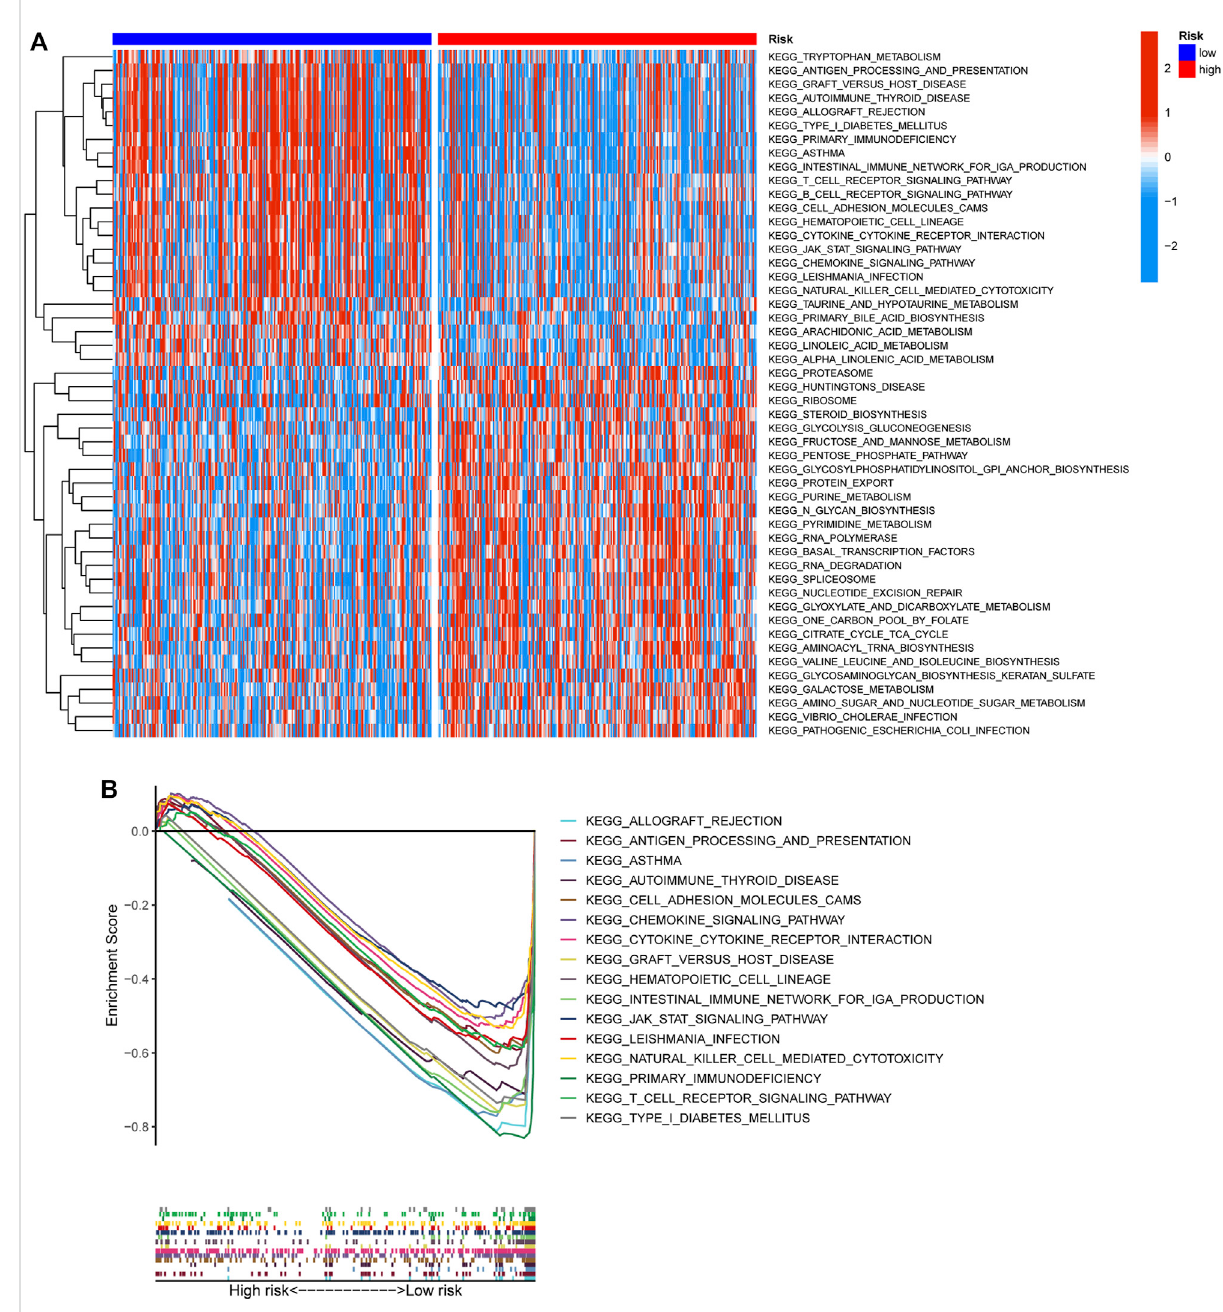
FIGURE 12 Functionalenrichmentcharacteristicsoftherisksignature. (A) DifferentactivitiesofKEGGpathwayscoredbyGSVAbetweenhigh-andlow-risk groups. (B) GSEA analysis showing the sixteen KEGG functional pathways enriched in low-risk